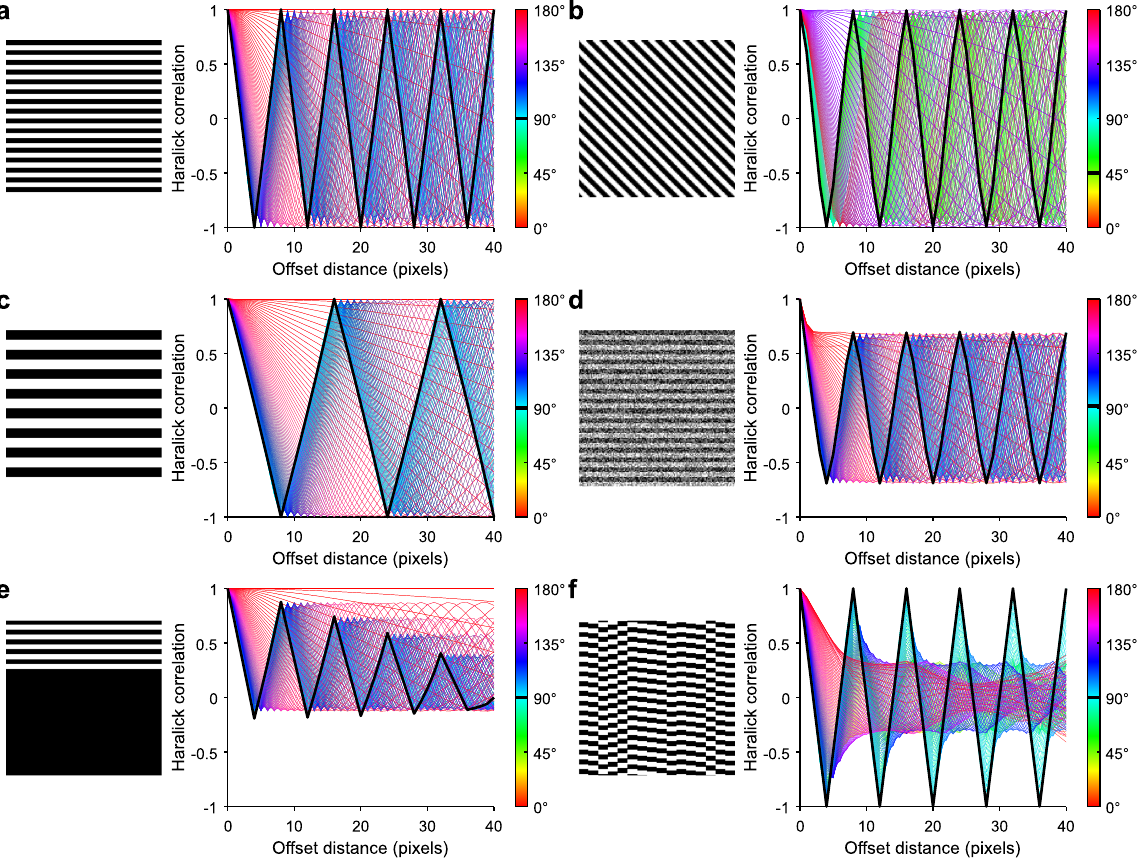
Figure 3. Haralick correlation metric in idealized images. ( a ) Horizontal stripes. ( b ) Diagonal stripes. ( c ) Horizontal stripes of a different frequency. ( d ) Horizontal stripes with noise added. ( e ) Horizontal stripes in one third of the image. ( f ) Bands with random vertical